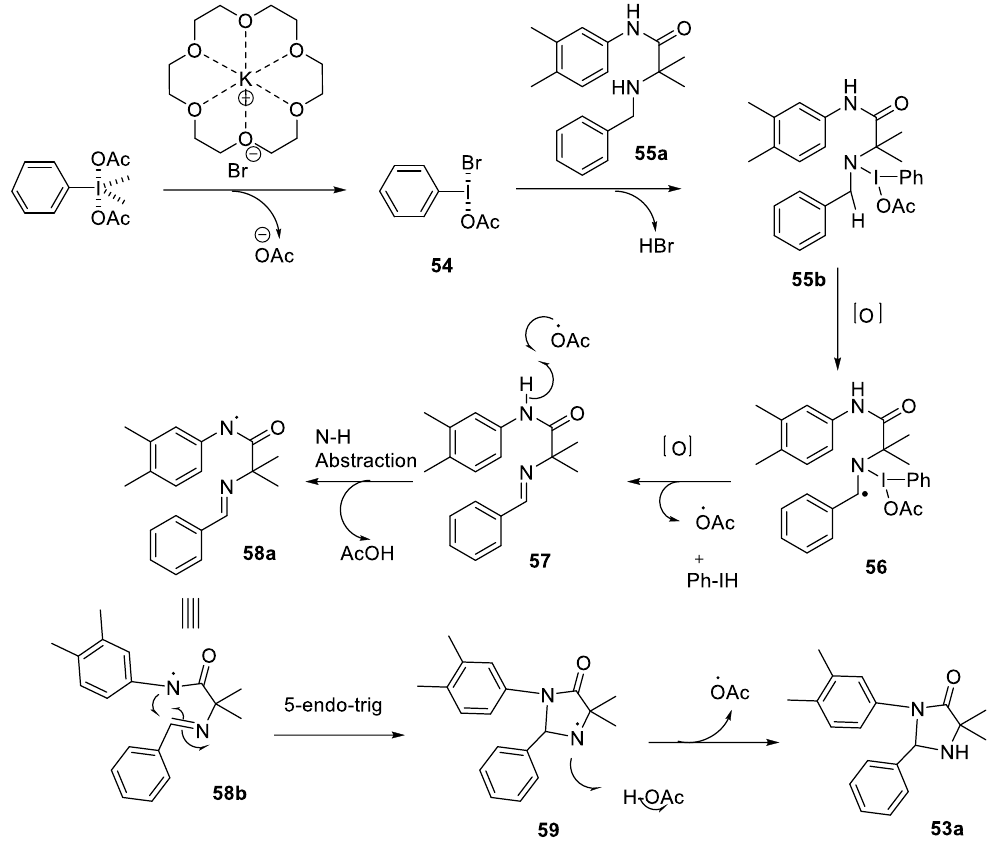
Figure 9. Proposed mechanism for the formation of 1,4-imidazolidinones.